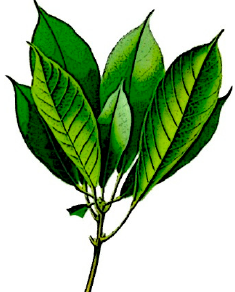
Figure 3. Khat leaves.